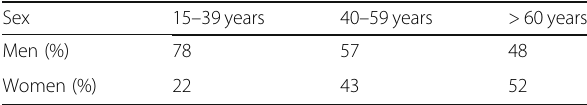
Table 6 Age characteristics of sudden